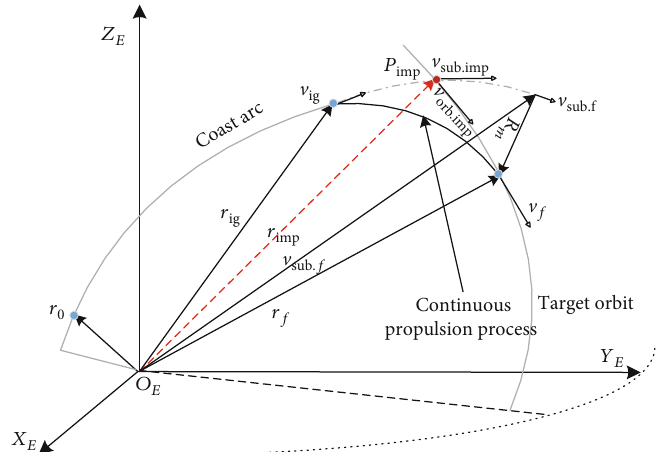
Figure 2: The principle of the pointing algorithm and the relationship between vectors.